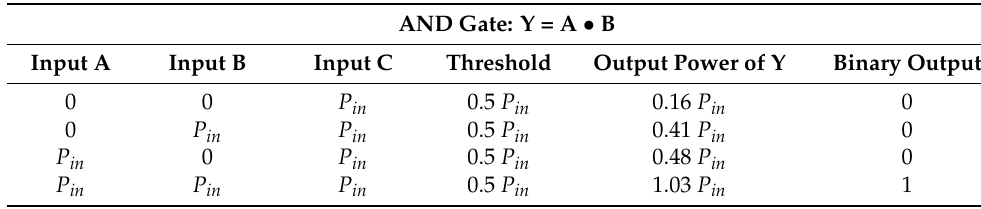
Table 6. Performance comparison between the proposed photonic AND logic gate and several ref- erence structures reported in other papers.